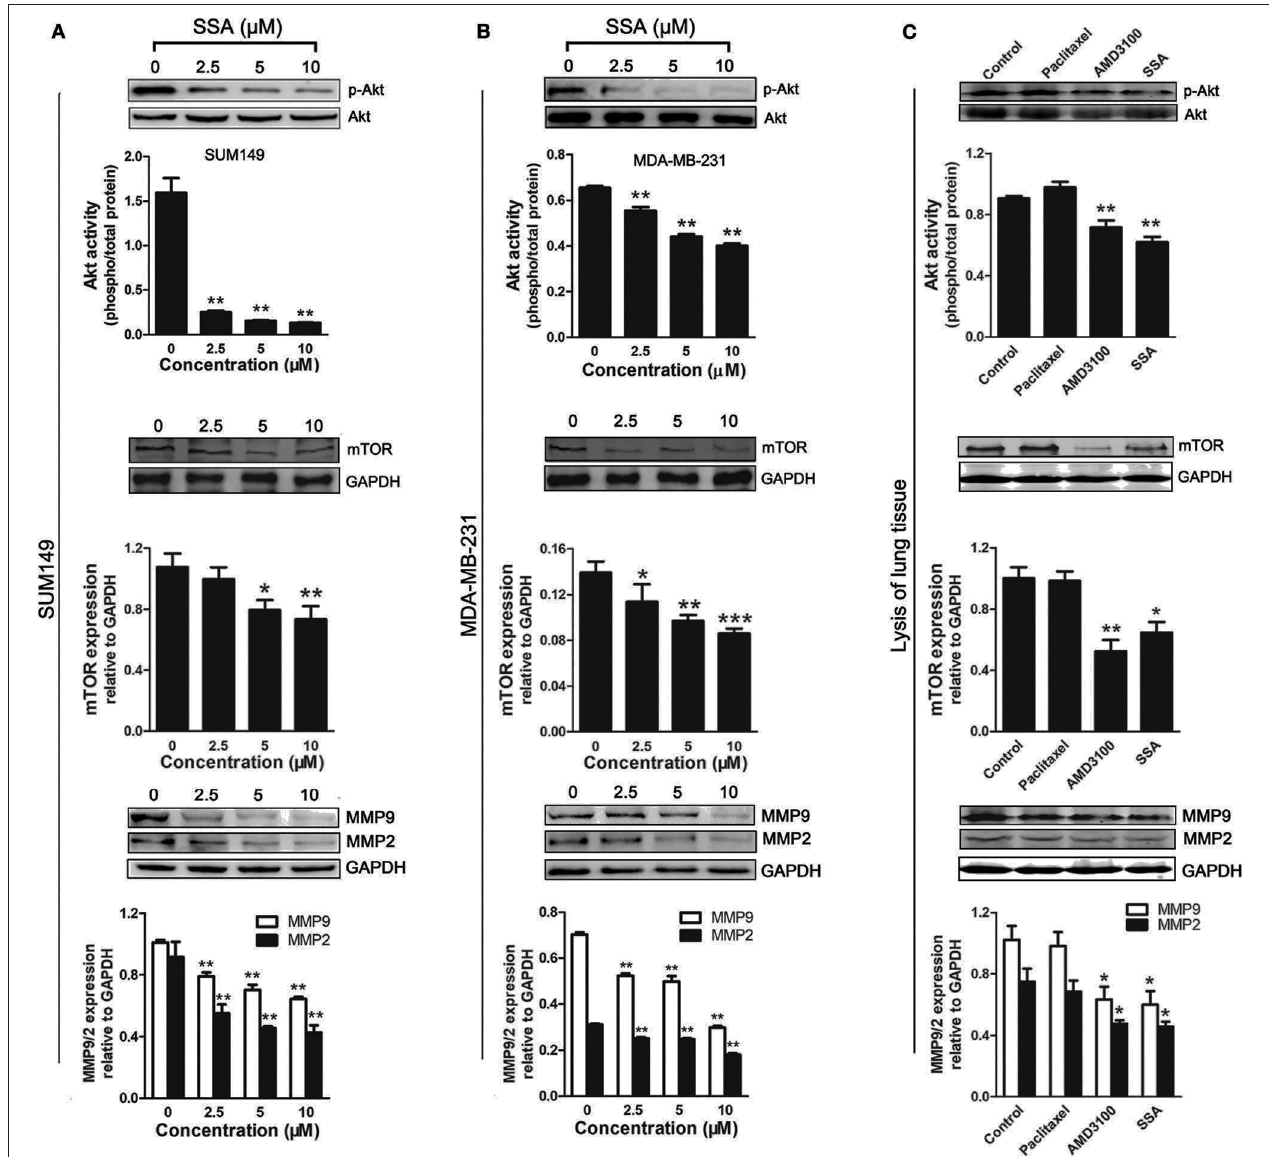
FIGURE 5 | Effect of SSA on the expression of phospho-Akt, mTOR, MMP-2, and MMP-9 in TNBC cells and lung tissue of 4T1-luc mice. Western blot analysis of phospho-Akt, mTOR, MMP-2, and MMP-9 expression in SUM149 (A) and MDA-MB-231 (B) cells after treatment with SSA at the indicated concentrations for 24h. Quantification of protein expression is shown below the Western blots. * p < 0.05; ** p < 0.01; *** p < 0.001 compared with 0 µ M of SSA. (C) Western blot analysis of phospho-Akt, mTOR, MMP-2, and MMP-9 expression in lung tissue of 4t1-luc mice after treatment with paclitaxel, AMD3100, and SSA for 2 weeks. Quantifications of C are shown below the Western blots. The independent experiments were performed in triplicate. * p < 0.05; ** p < 0.01 compared with control